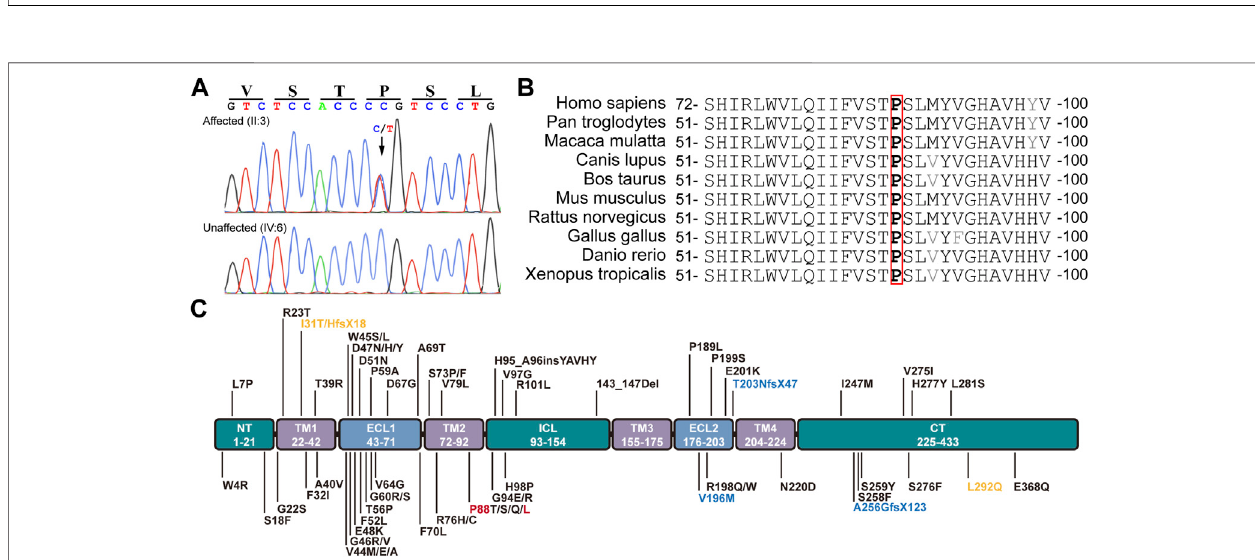
FIGURE 2 | Mutation identi fi cation and analyses. (A) The c.262C > T heterozygous mutation in GJA8 was con fi rmed in all affected but not in unaffected family membersbytheSangersequencing.Thismutationresultsinap.P88LaminoacidchangeinthesecondtransmembranedomaininCx50. (B) TheP88(highlightedinred box) and neighbor amino acid residues were conserved in the indicated vertebrates. (C) Known pathogenic mutations in human Cx50 are listed according to their positionsinthefunctionaldomains.Dominantmutationsarelistedinblack,recessivemutationsinblue,anduncertainmutationsinorange.Lettersinreddenotethe mutation in this study. NT (N-terminus), ICL (intracellular loop), and CT (C-terminus) are intracellular regions (in green boxes). TM1-4 indicate the four transmembrane regions (in purple boxes). ECL1-2 are extracellular loops (in light blue boxes).